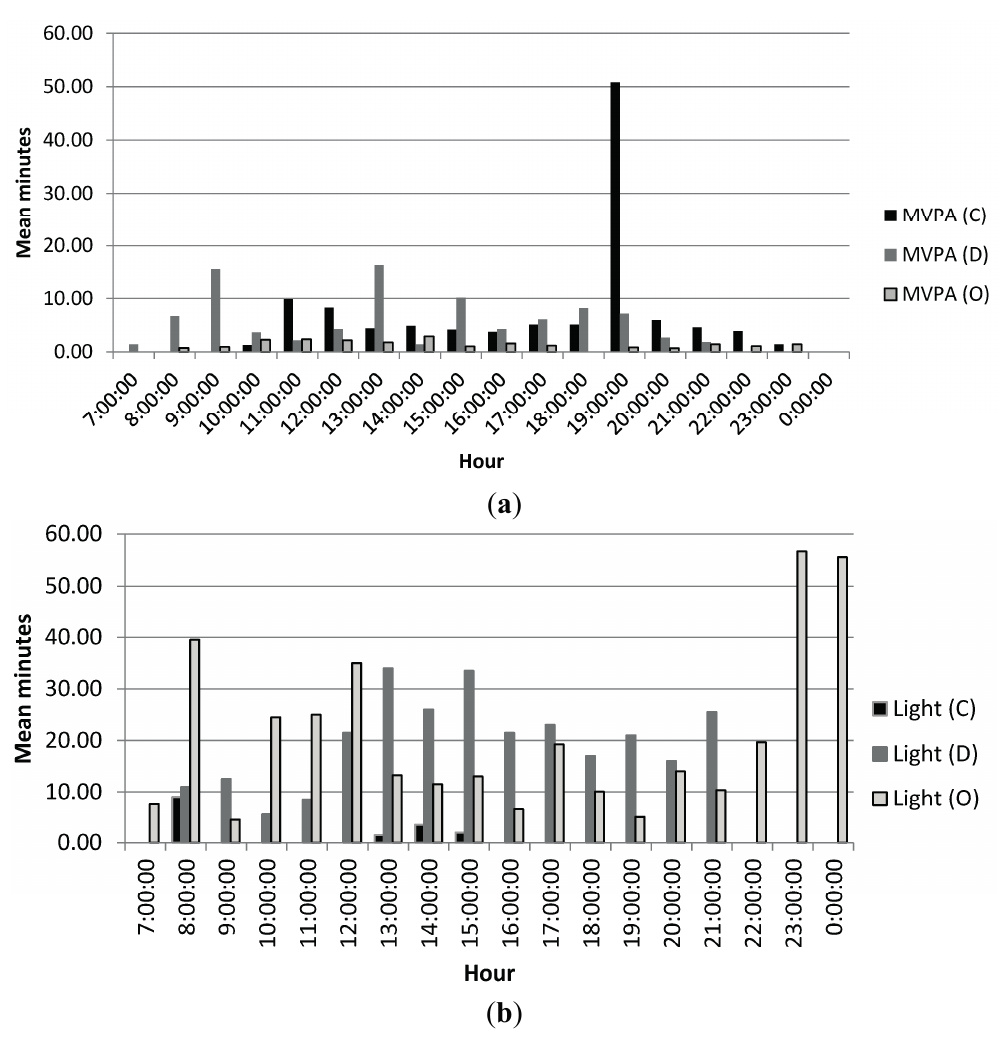
Figure 2. ( a ) Mean daily MVPA for walkers; ( b ) Mean daily light intensity PA for